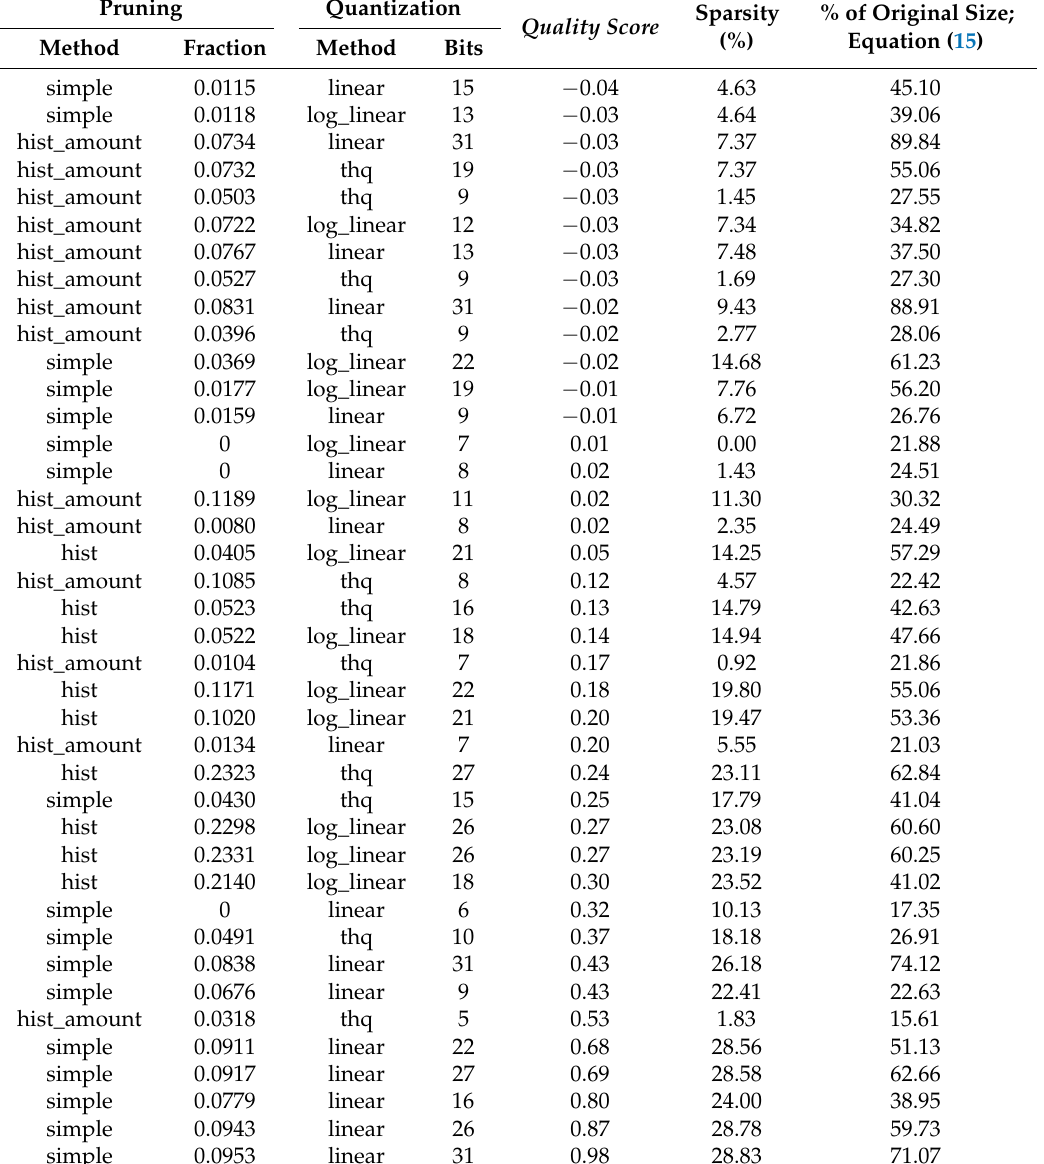
Table A6. [PM2.5] Results for pruned and quantized model with single retraining epoch added.